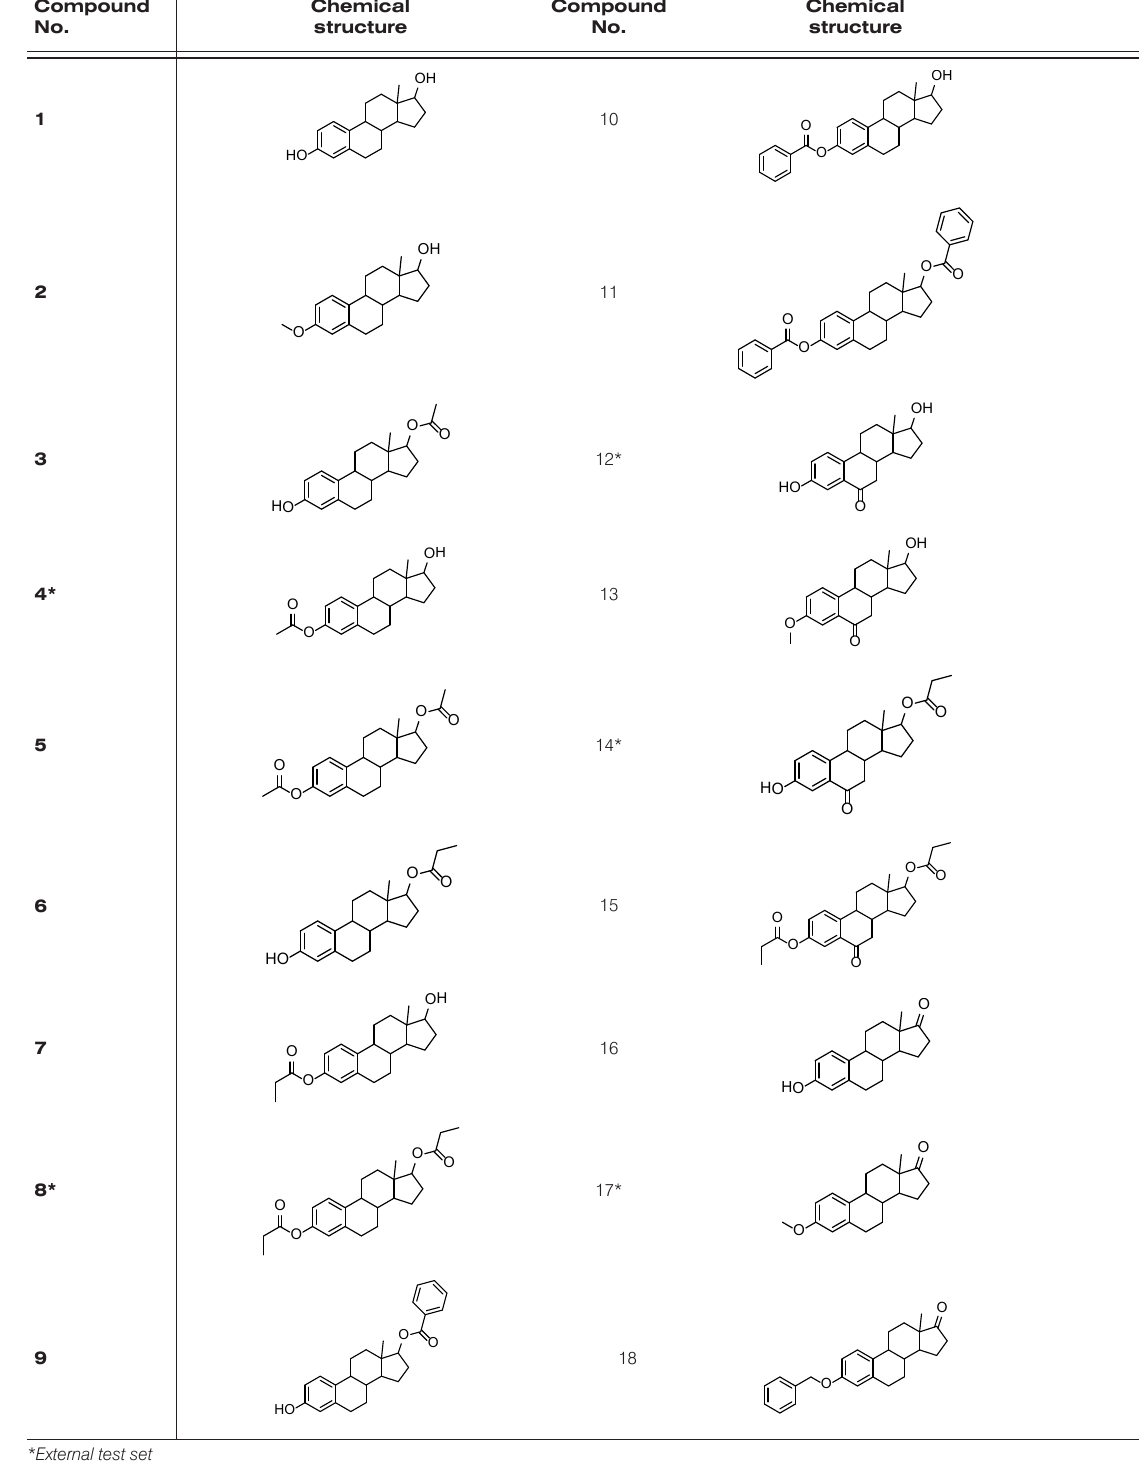
Table 1. The chemical structures of the compounds studied. Compound